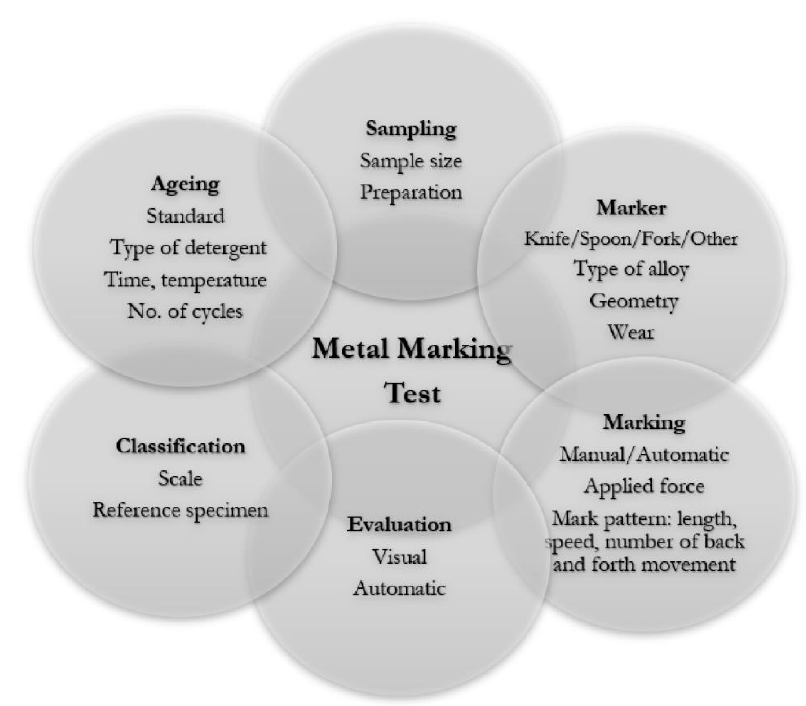
Figure 8. Set of parameters to take into account for a metal marking test.